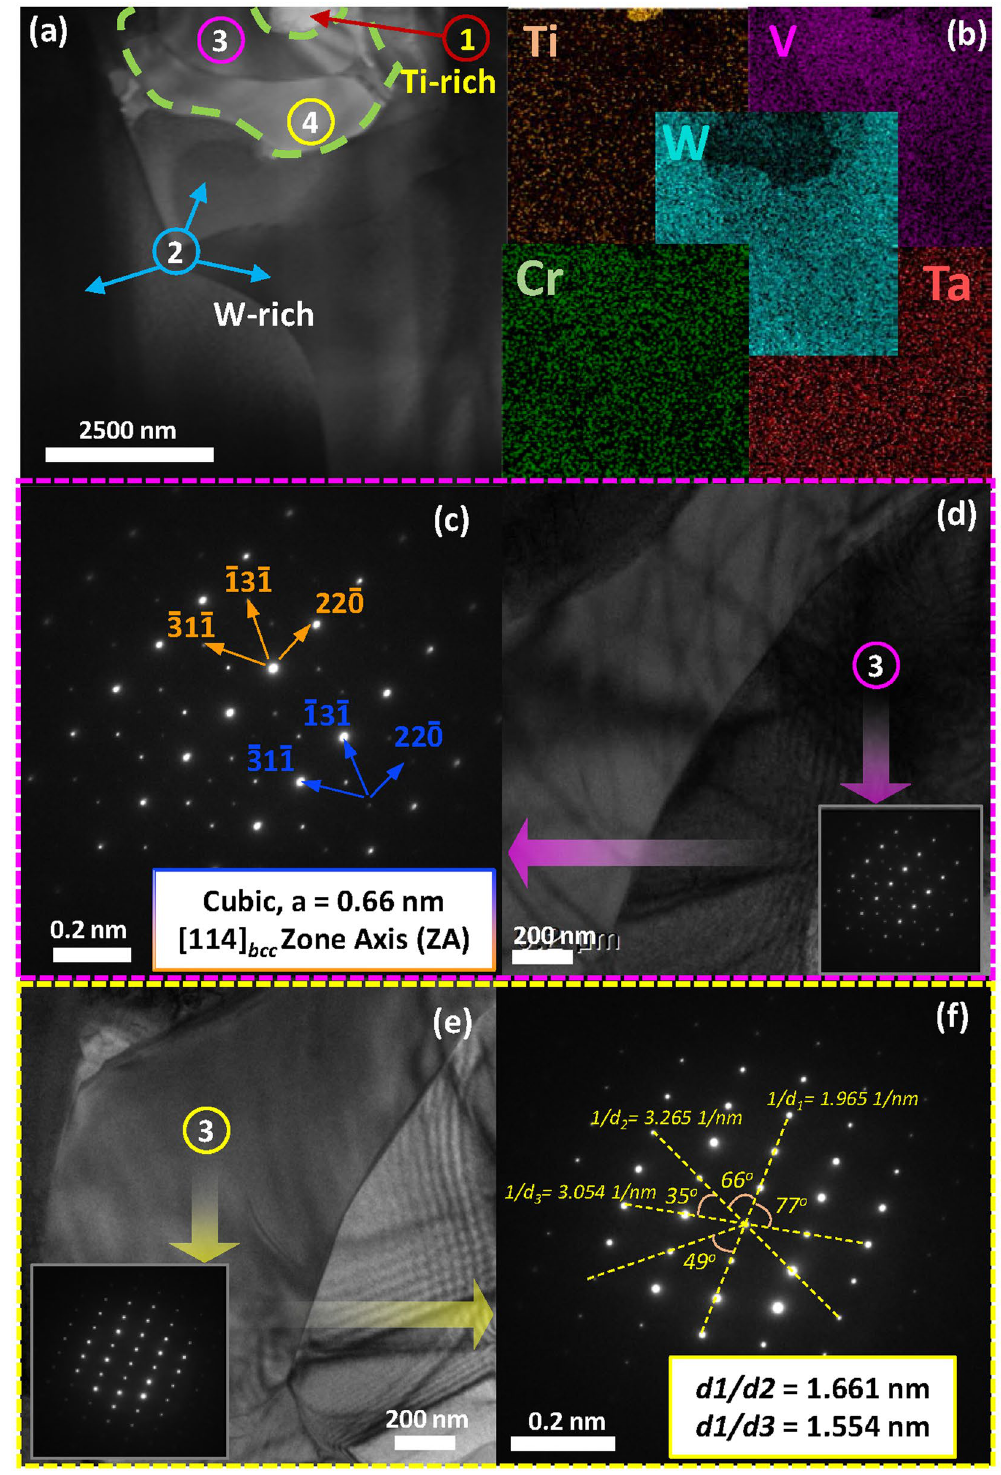
Figure 5. ( a ) TEM microstructure, ( b ) elemental mapping, ( c and d ) SADP of the C15 laves phase and ( e and f ) SADP of a complex crystal structure dissimilar to any of the fundamental crystal structures, as observed in 90 W s